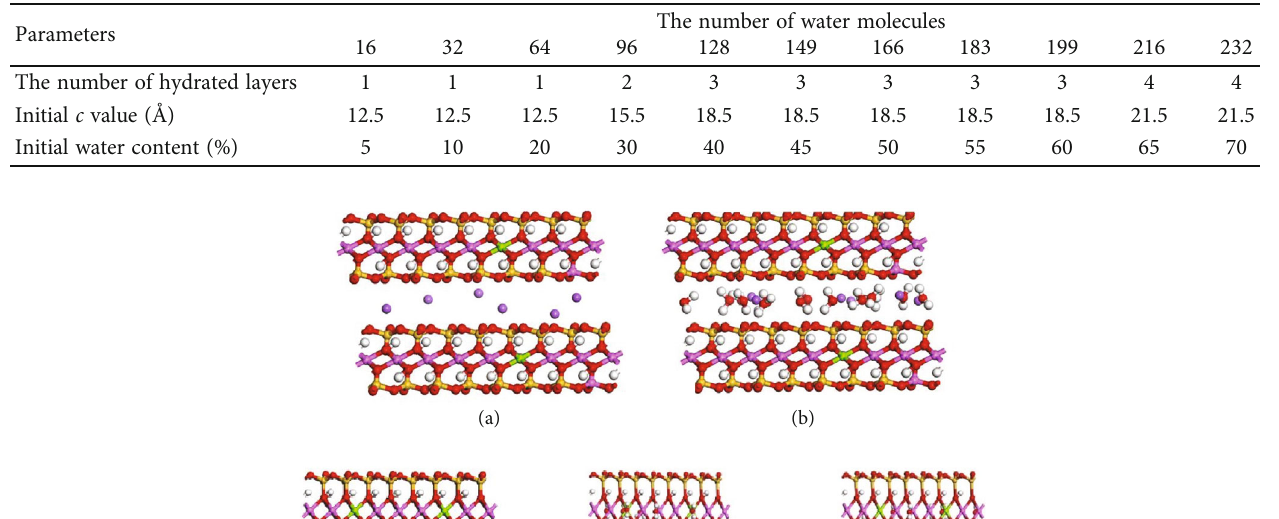
Table 1: The parameters of Mnt with di ff erent numbers of water molecules between layers.